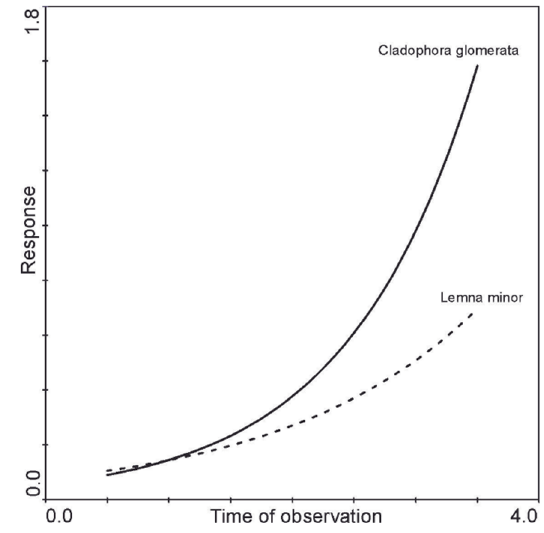
Figure 8. C. glomerata and L. minor response curves to time of observation (4 month) gradient mod ‐